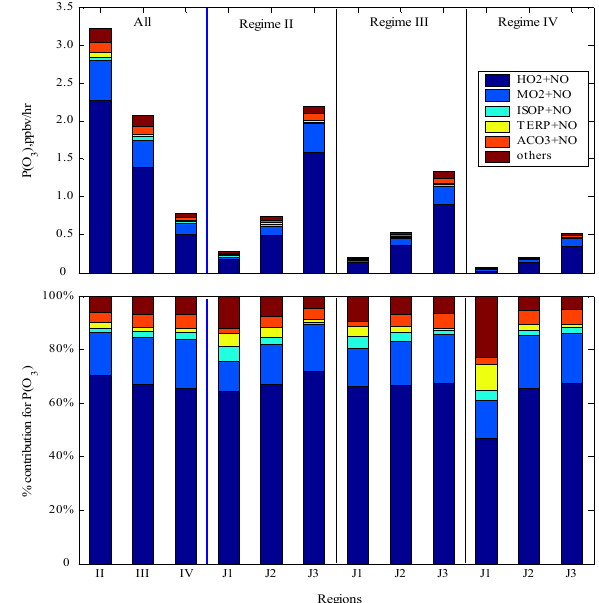
Fig. 12. Itemization of P (O 3 ) calculated in different regimes. The 10-min average data of P (O 3 ) are categorized into three classes by j (O 1 D) (s − 1 ) values: (J1) j (O 1 D) < 10 − 6 s − 1 , (J2) 10 − 5 s − 1 > j (O 1 D) > 10 − 6 s − 1 and (J3) j (O 1 D) > 10 − 5 s − 1 . TERP: peroxy radicals from monoterpenes. 0.20 ppbv/hr at J2 level and 1.33 and 0.51 ppbv/hr at J3